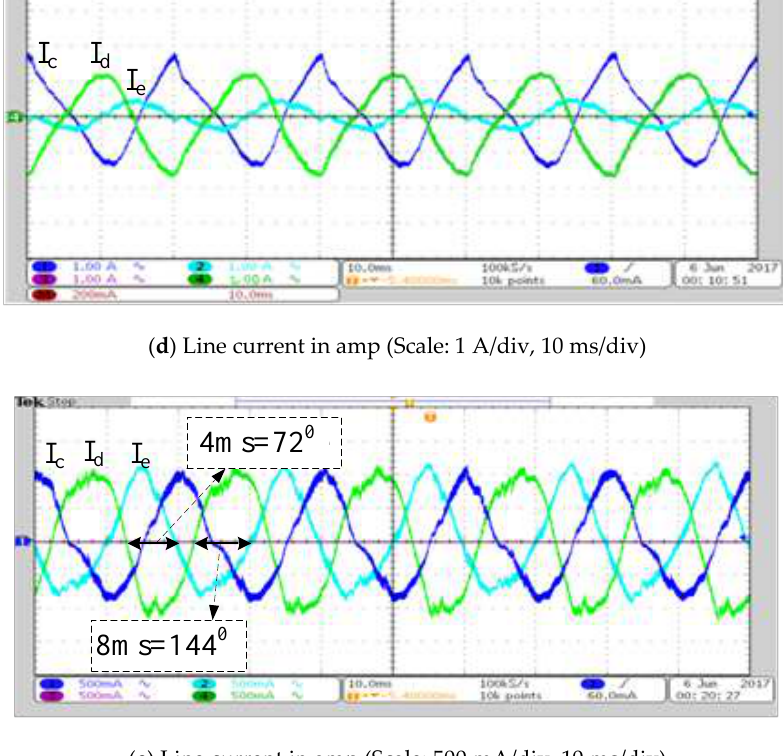
Figure 6. Line current at ( a ) Healthy operation; ( b ) 1-Ph open circuit fault without control strategy; ( c ) 1-Ph open circuit fault with control strategy; ( d ) A2-Ph open circuit fault without control strategy; ( e ) A2-Ph open circuit fault with control strategy.